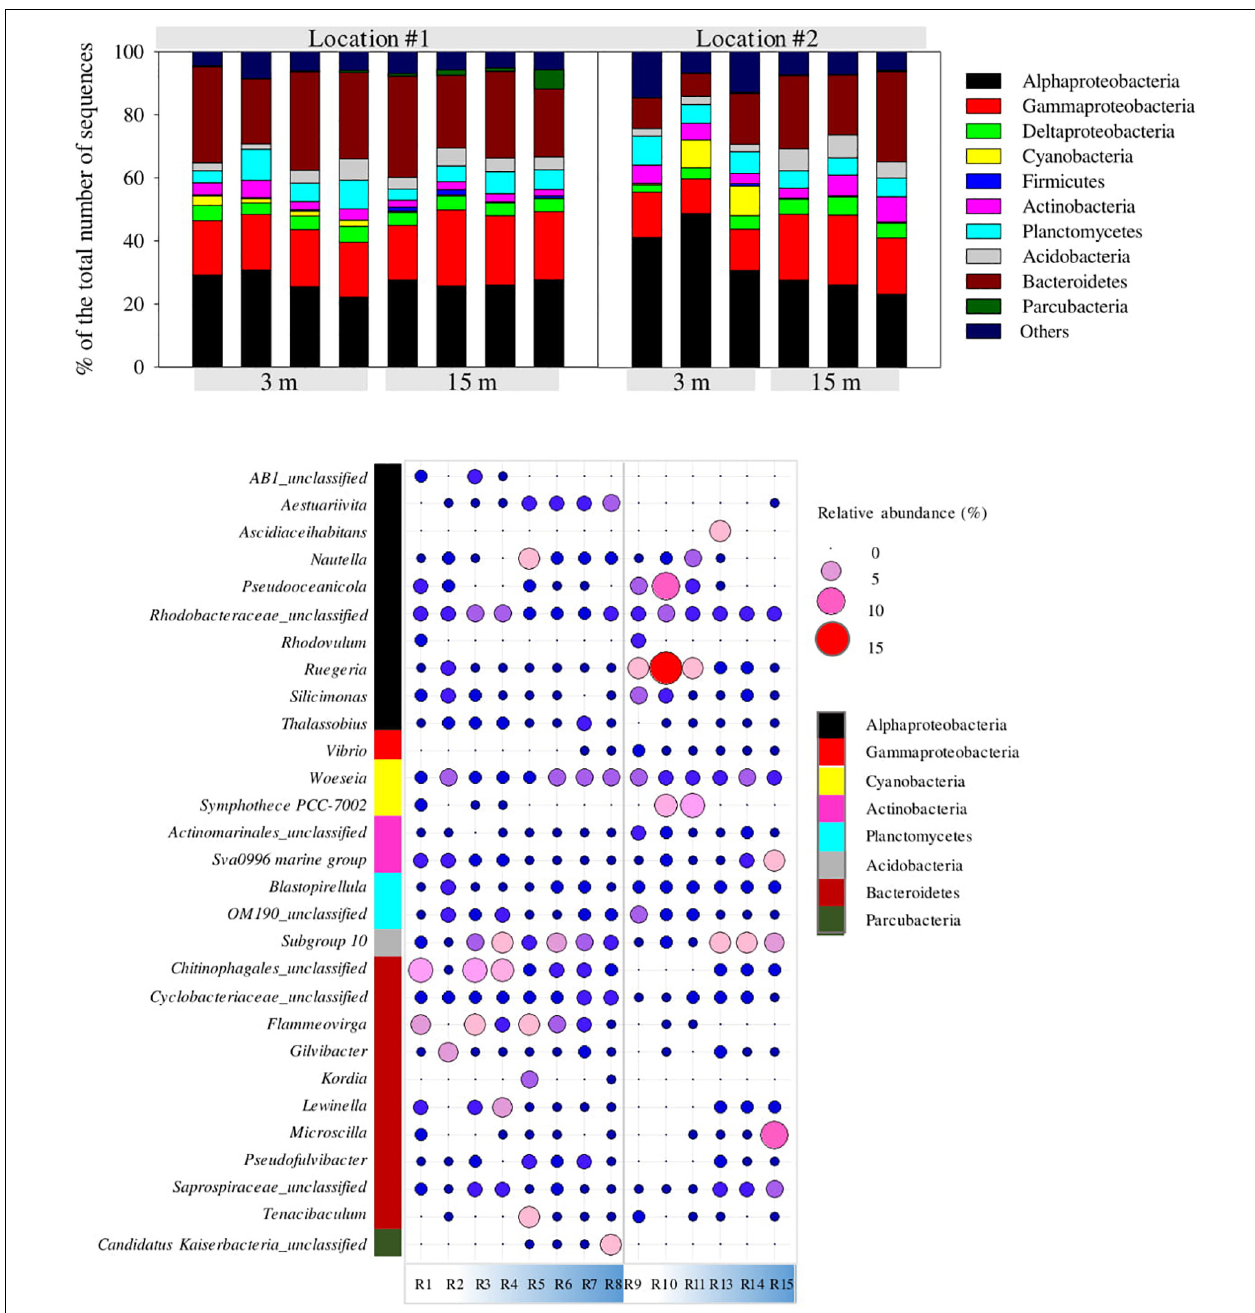
FIGURE 10 | Changes in the relative abundances (% of total number of sequences) of the most dominant bacterial classes/phyla within the fouling bacterial communities developed on panels exposed at 3 and 15 m depths in both locations #1 and #2 (bar plot at top ). Changes in the relative abundances of the most dominant bacterial genera within developed biofilms in locations #1 and #2 (bubble plot at bottom